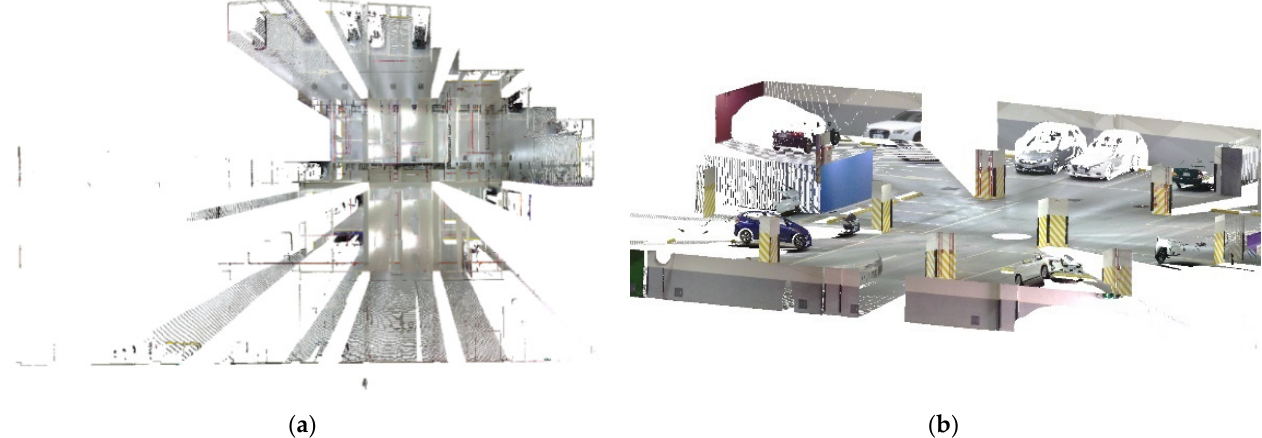
Figure 3. Top and side views of the collected points by a FARO Focus S350 in a single station (colored by RGB). ( a ) Top view; ( b ) Side view.